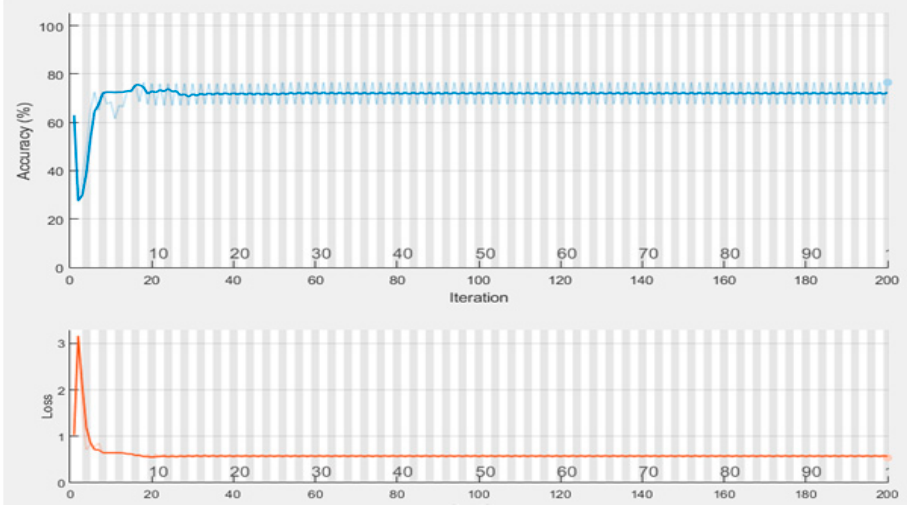
Figure 3. Training progress of the secure GRU-RNN for the WDBC dataset.